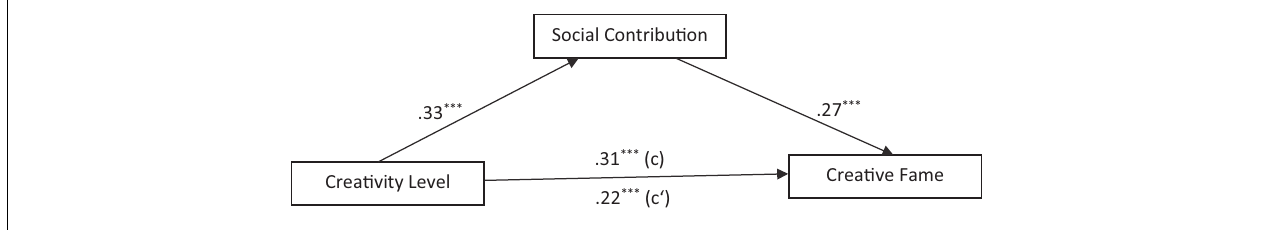
FIGURE 1 | Mediation model of social contribution between creativity level and creative fame: aesthetic salience areas. ∗∗∗ p < 0.001.